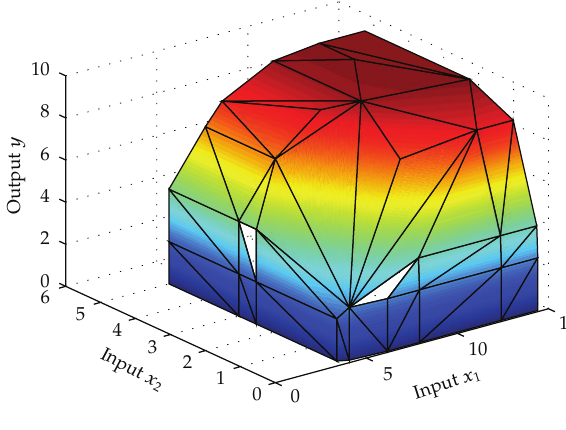
Figure 4: E ffi cient